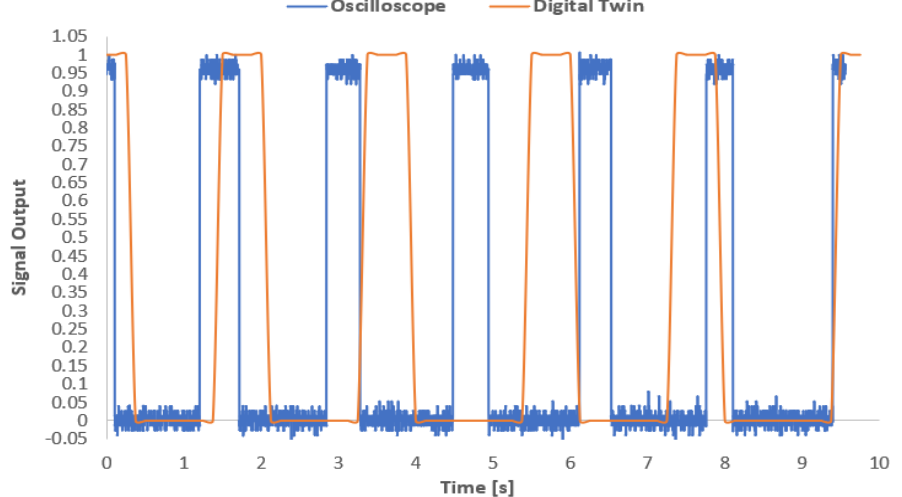
Figure 7. Oscilloscope output of the PWM waveform, A to C is the measurement runtime at 2.5 min while point B marks the start of pulse modulation and section D to E is where the PID/PWM simulation is validated.